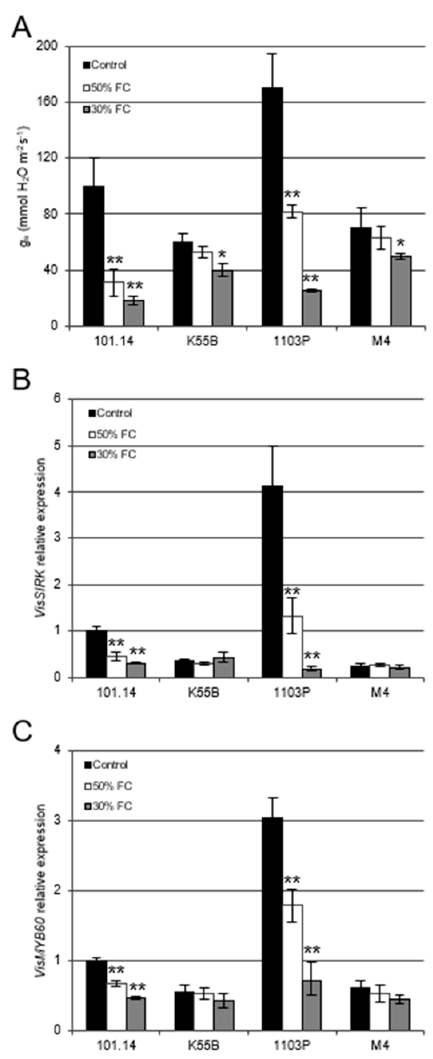
Figure 3. VvMYB60 expression in the grape leaf correlates with stomatal conductance. ( A ) Comparison of g s in leaves from control and stressed plants at 50% and 30% FC. ( B , C ) Comparison of VisSIRK ( B ) and VisMYB60 ( C ) expression in leaves from plants grown under control conditions (80% FC) or maintained for three consecutive days at 50% or 30% FC. Values represent means ± standard errors. Gene expression was normalized to the expression of the G3PDH gene. Double (**) and single (*) asterisks indicate values significantly different from the untreated control at p < 0.01 and p < 0.05, respectively (ANOVA).